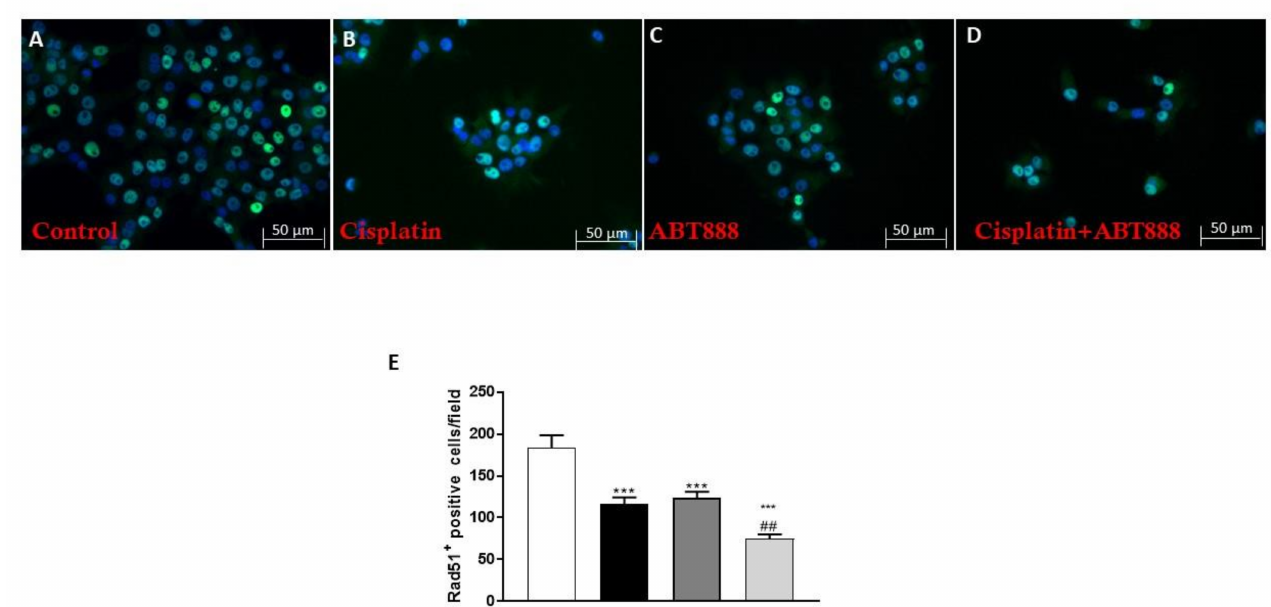
Figure 7. Effect of ABT888 and cisplatin on RAD51 levels on CAL27 cell line. Immunofluorescence assay revealed a marked expression of RAD51 expression in the control group ( A ), while the combinatory treatment with ABT888 and cisplatin ( D ) significantly reduced its expression compared to the single treatments ( B , C ). ( E ) *** p < 0.001 vs. the control; ## p < 0.01 vs. cisplatin group.